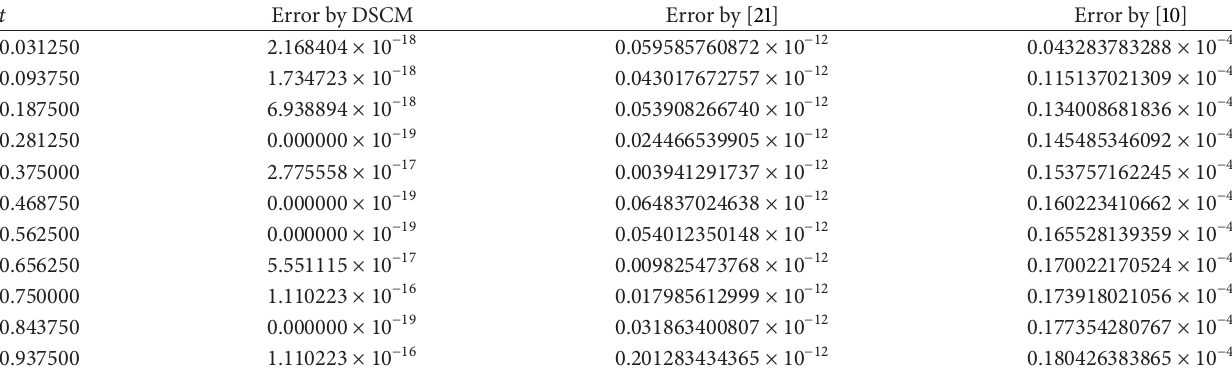
Table 1: The absolute errors of DSCM ( 𝜙 1 = 0.85, 𝜙 2 = 0.99 ) and the methods reported in [10, 21]; 𝛼 = 0.5 .